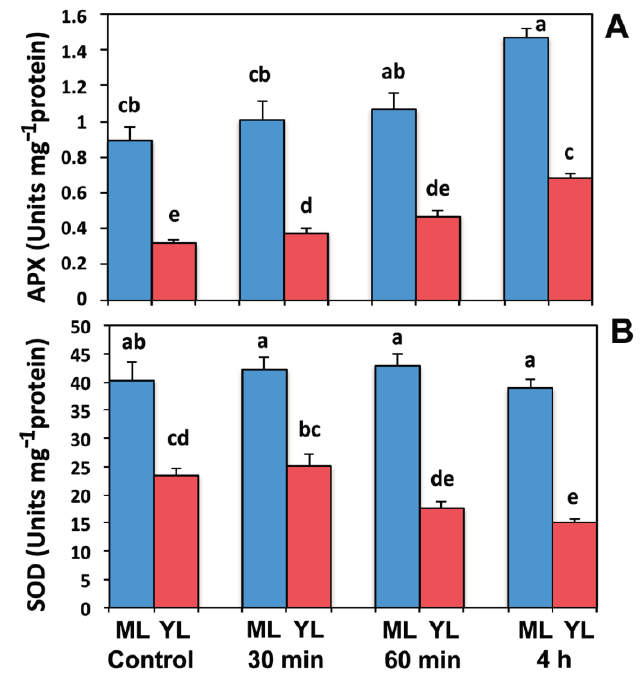
Figure 5. Changes of ( A ) ascorbate peroxidase activity, and ( B ) superoxidase dismutase activity, of control, and after 30 min, 60 min, and 4 h Pq exposure of A. thaliana mature (ML) and young leaves (YL). Blue columns: mature leaves; red columns: young leaves. Data shown are means ± SE that is indicated by bars ( n = 6). Columns with different lowercase letters are significantly different ( p <